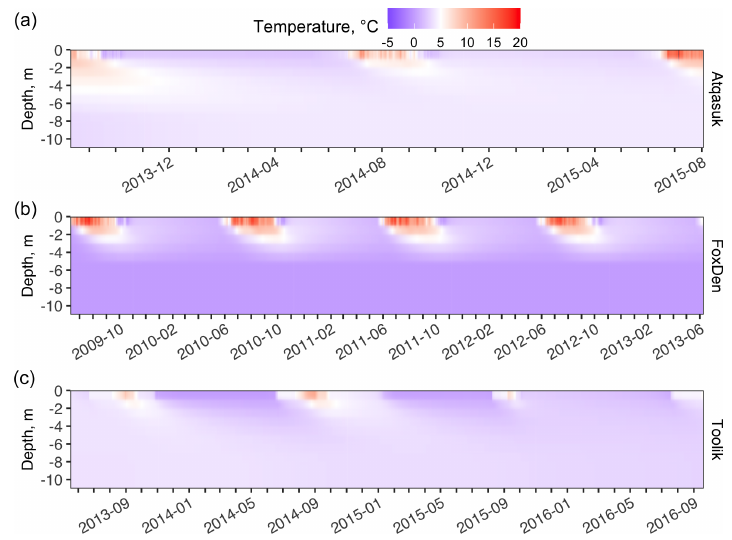
Figure C2. Baseline lake sediment temperature over the simulation period for Atqasuk (a) , Fox Den (b) , and Toolik Lake (c) from 0 to 10m